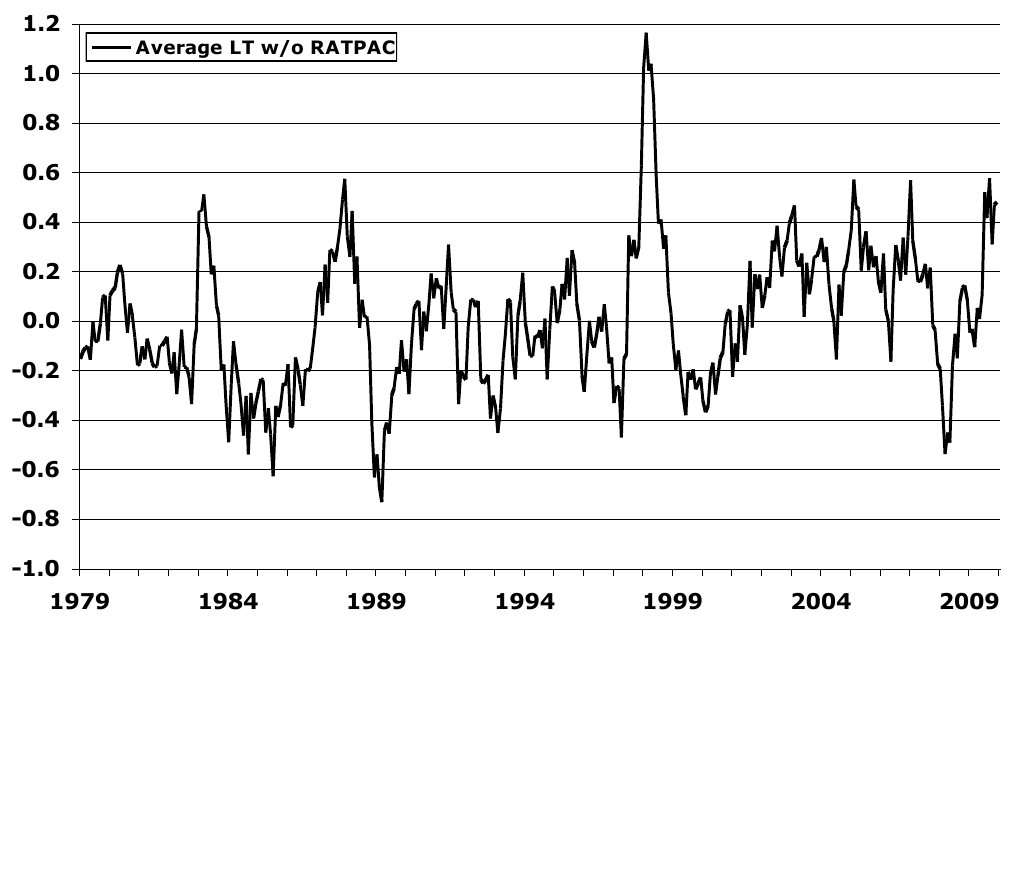
Figure 1. Time series of average monthly anomalies of T RICH, and